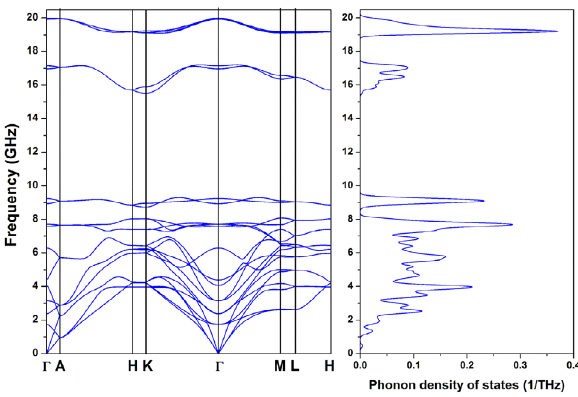
Fig. 2 Calculated phonon dispersion relations of V 2 SnC.